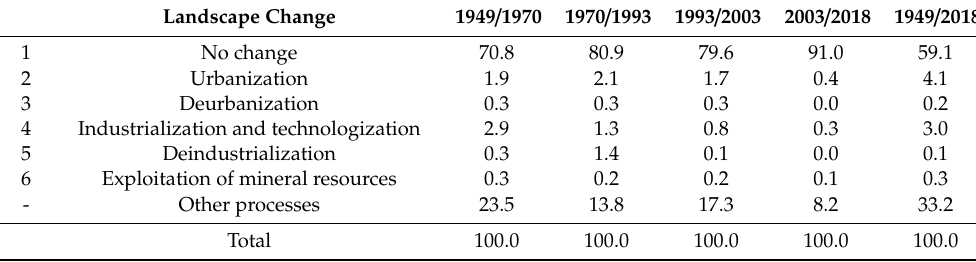
Table 4. Landscape change categories and their proportion rates in percent. Landscape